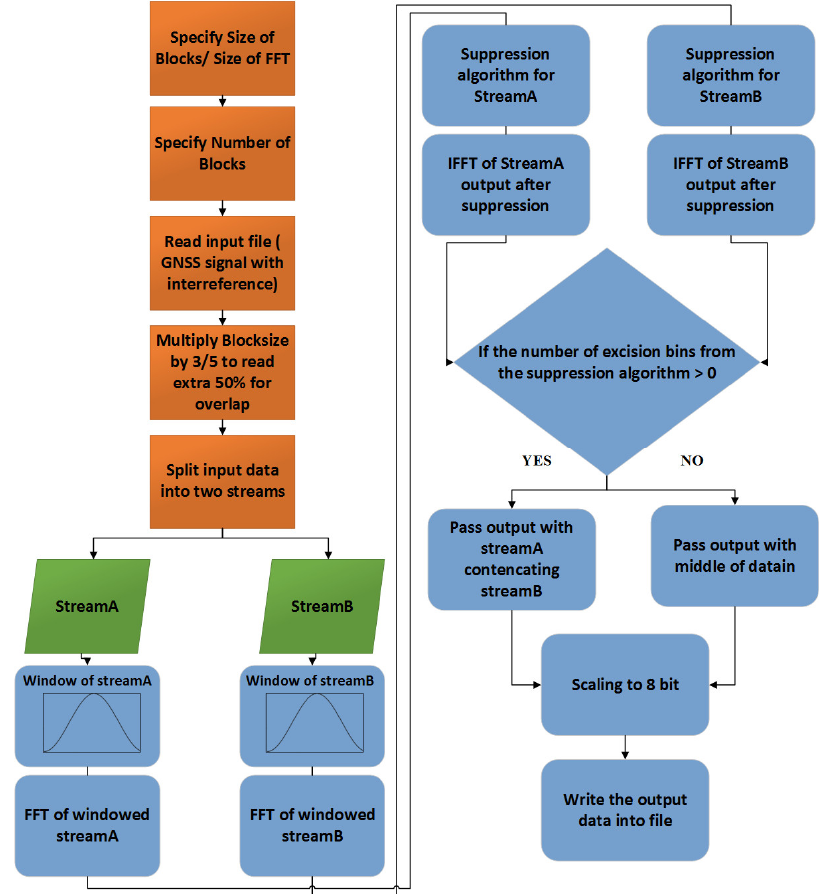
Figure 13. Flowchart of the FFT excision algorithm .